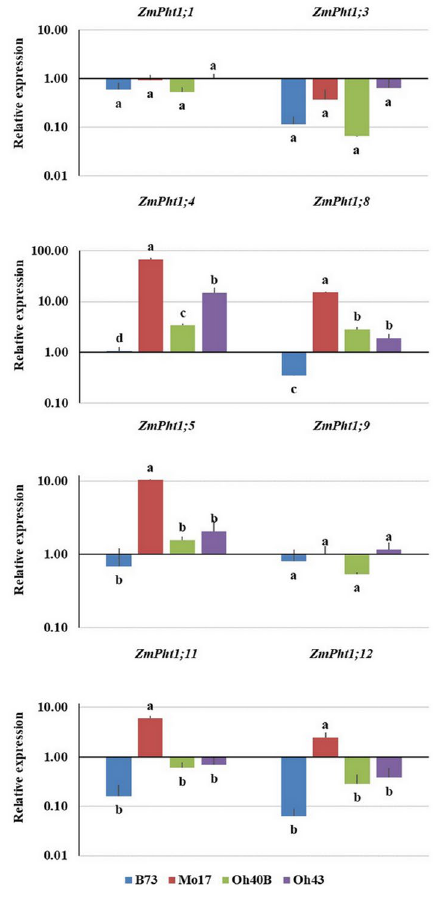
Figure 2. Normalized relative expression of phosphate transporters ( ZmPht1 ) in mycorrhizal roots of Zea mays plants belonging to four inbred lines, grown in symbiosis with Rhizoglomus irregulare , under low phosphorus availability (0.47 mg kg −1 ). Data are presented as mean values ± SEM (n = 6). For each transporter gene, same letters indicate no significant differences ( P > 0.05) between maize lines by Tukey’s HSD or Tamhane T2 test. All expression levels were normalized against the ZmActin1